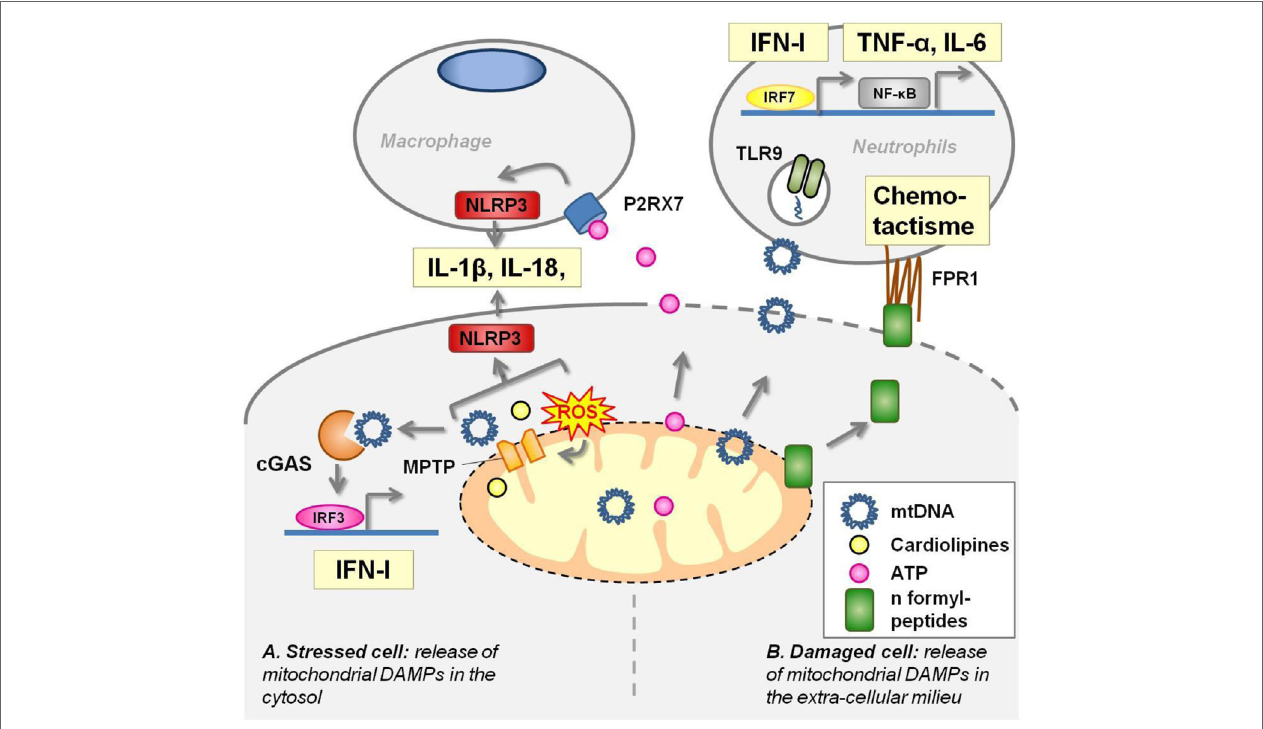
FiGURe 2 | Mitochondrial components act as damage-associated molecular patterns (DAMPS). (A) In stressed cells [e.g., viral infection, defect of autophagy, toll-like receptors (TLRs) ligation], mitochondrial transition pore (MPTP) opening extrudes several mitochondrial components in the cytoplasm where they activate pattern recognition receptors (PRRs). Mitochondrial DNA (mtDNA) activates cyclic GMP–AMP synthase (cGAS) receptor and NLRP3 inflammasome. Cardiolipin and mtROS trigger NLRP3 inflammasome. (B) Damaged cells release mitochondrial DAMPs into the extracellular milieu where they stimulate PRRs harbored by macrophages and neutrophils. Adenosine triphosphate (ATP) leads to P2X7 opening at the macrophage membrane and triggers NLRP3 inflammasome. mtDNA unmethylated CpG motifs are recognized by TLR9. N-formylmethionine residues in mitochondrial proteins are sensed by the formyl-peptide receptors expressed by neutrophils, driving chemotactism and activation of these